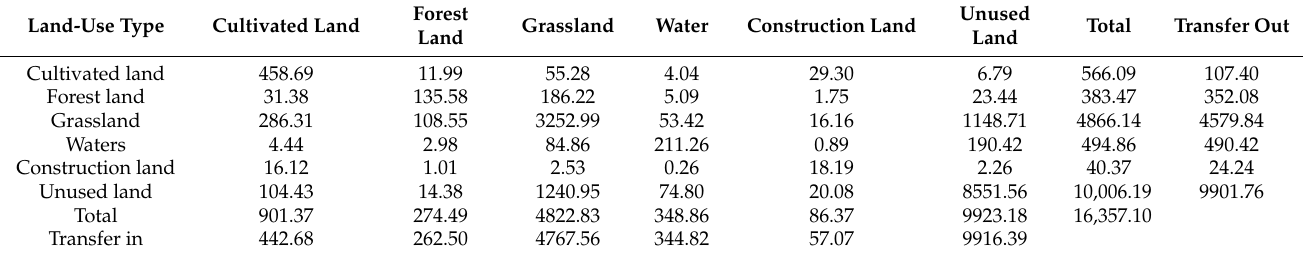
Table 3. Land-use transfer matrix for Xinjiang from 1990 to 2020 ( × 10 4 hm 2 ).